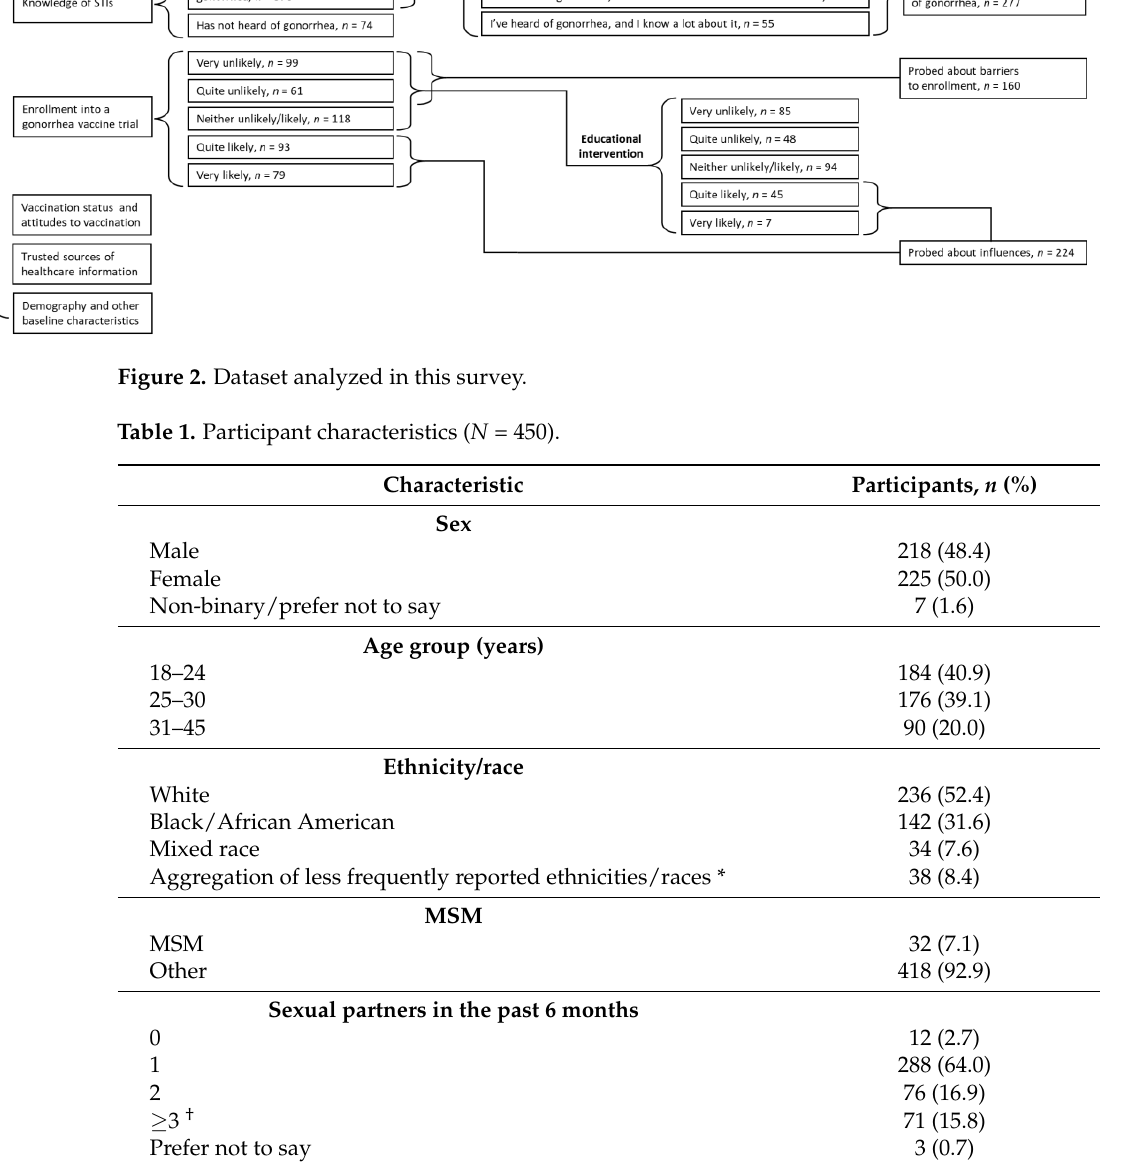
Table 1. Participant characteristics ( N = 450).